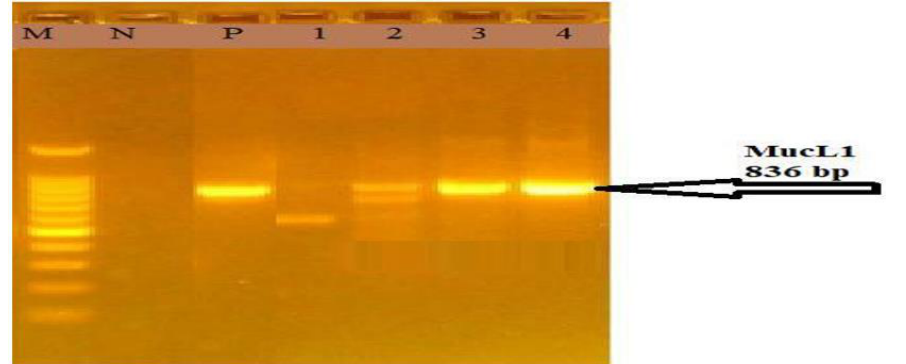
Fig. 9. Agarose gel electrophoresis of 836 bp specific PCR product for MucL1 gene for Mucor spp. using 1.5% agarose gel at 90V for 1hr. in 1x TBE buffer and visualized under transilluminator UV after staining by ethidium bromide. Lane M: 100 bp DNA ladder, lane (2, 3, 4): positive result, lane N: negative control and lane P: positive control